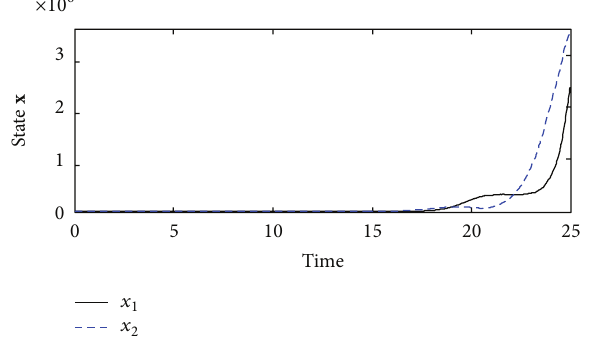
Figure 1: The trajectories of uncontrolled system state x (𝑡) .